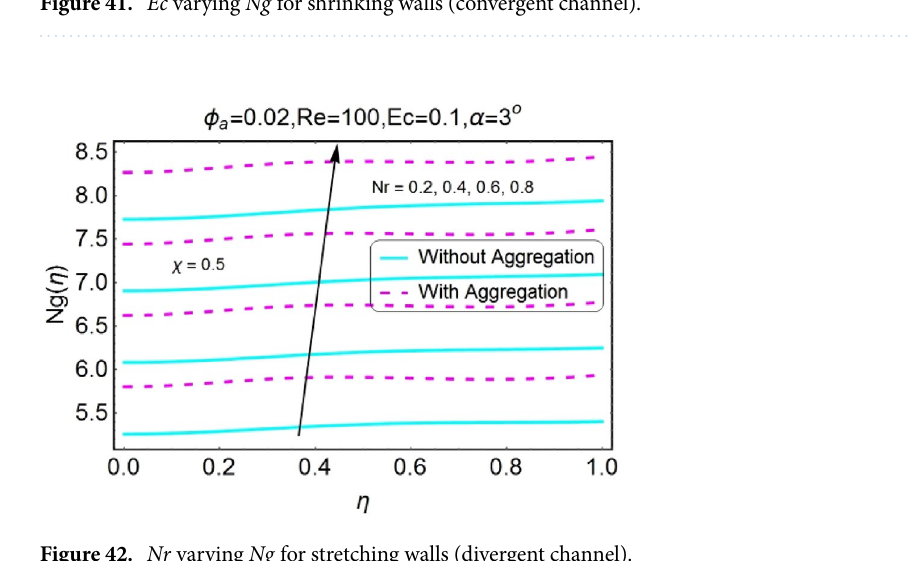
Figure 42. Nr varying Ng for stretching walls (divergent